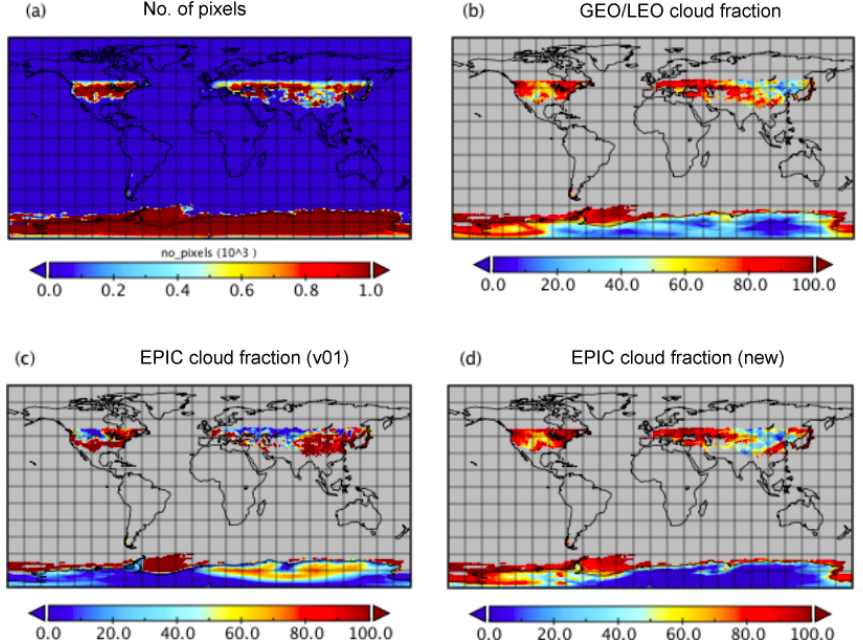
Figure 9. (a) Number of ice/snow pixels and monthly mean cloud fractions derived from the (b) GEO/LEO composites, (c) original EPIC cloud mask algorithm, and (d) new algorithm in 1 ◦ × 1 ◦ grids for January